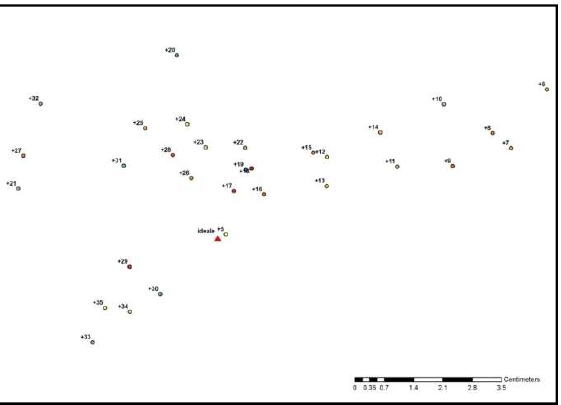
Figura 13 : Planimetrical barycentric dispersion : Planimetrical barycentric